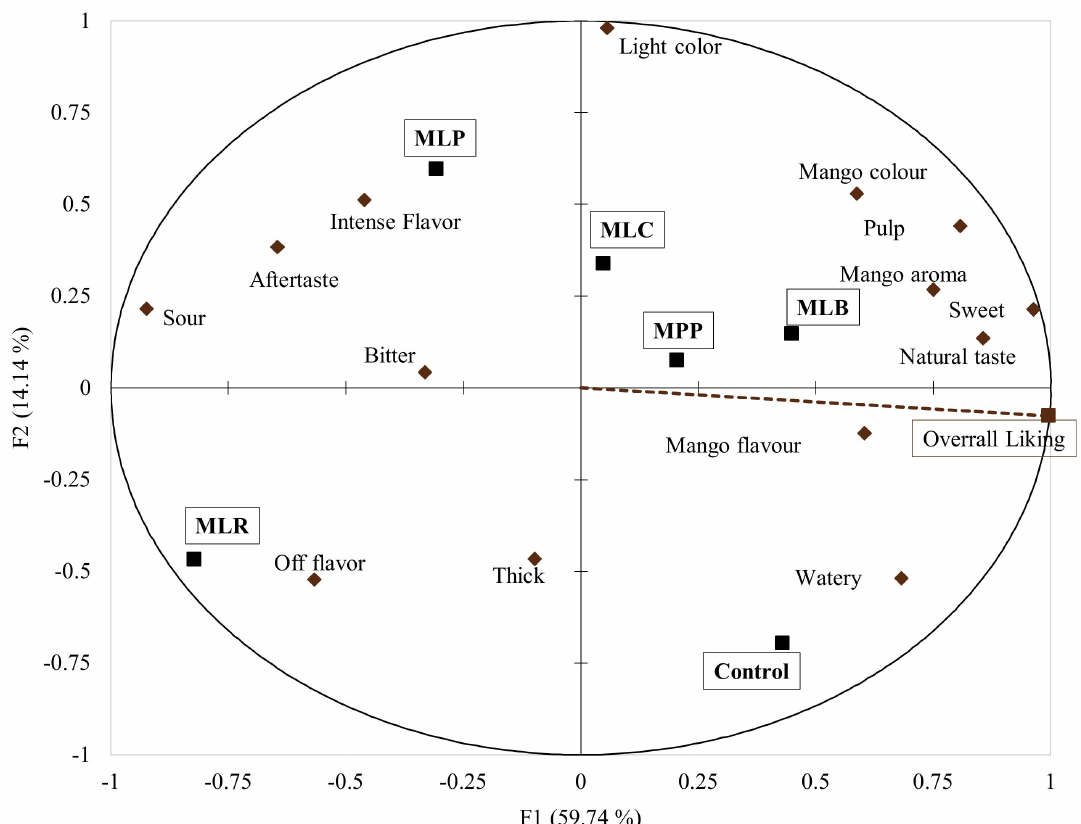
Figure 4. Multifactorial analysis (MFA) using overall liking ratings and CATA ( n = 80). Mango juices fermented with MLB— Levilactobacillus brevis ; MLC— Lacticaseibacillus casei ; MLP— Lactiplantibacillus plantarum subsp. plantarum ; MLR— Lacticaseibacillus rhamnosus ; MPP— Pediococcus pentosaceus . Control is mango juice with no lactic acid bacteria under the same conditions of fermentation (24